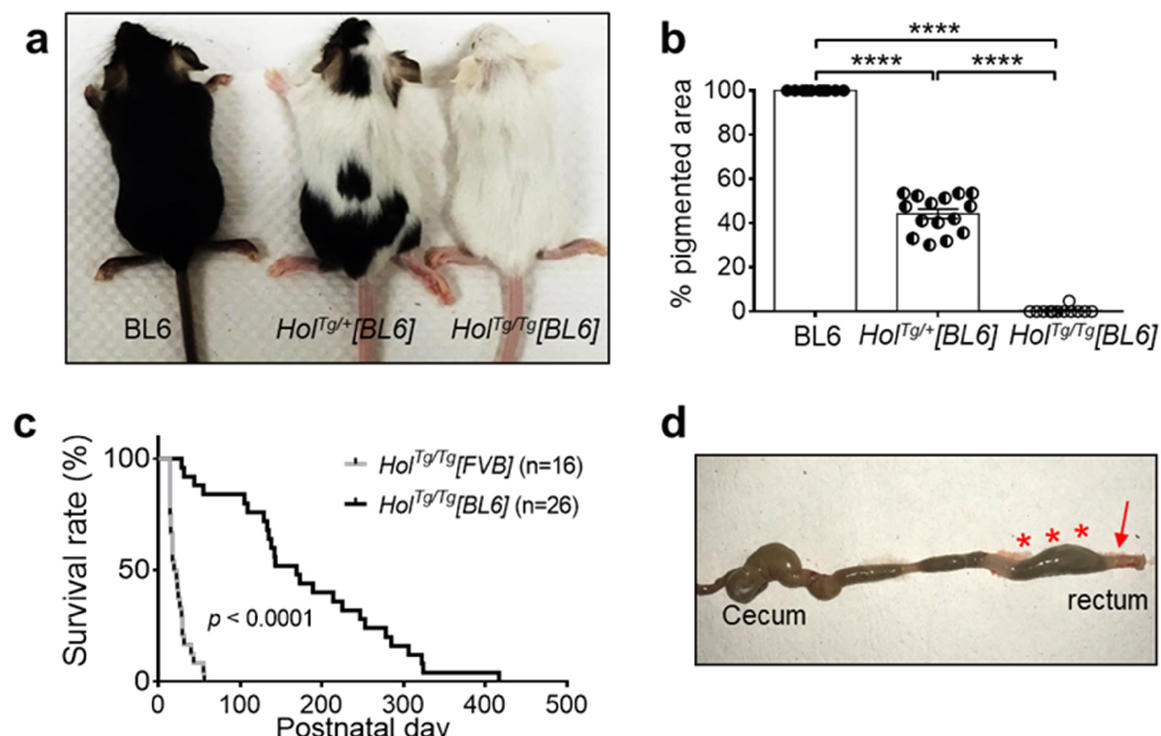
Figure 1. The C57BL/6N genetic background delays megacolon-associated death in Hol Tg/Tg mice. ( a – b ) Allele dosage-dependent decrease of pigmentation in P20 Hol Tg/Tg [BL6] mice. **** p < 0.0001, one-way ANOVA with post-hoc Sidak’s test. ( c ) Comparison of survival rates between Hol Tg/Tg [BL6] and Hol Tg/Tg [FVB] mice. **** p < 0.0001, Mantel–Cox test. ( d ) Hol Tg/Tg [BL6] mice die from complications of megacolon, as evidenced in this euthanized P31 animal by the blockage in the distal colon and rectum (arrow) and accumulation of fecal material in more proximal regions (asterisks).